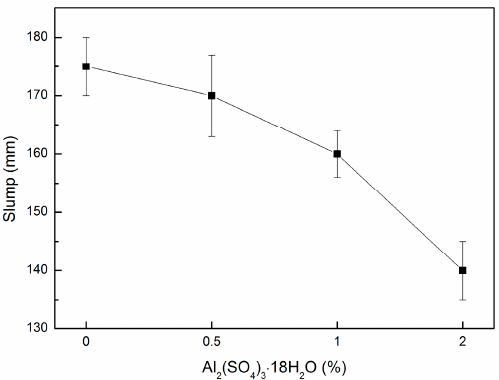
Figure 5. E ff ect of aluminum sulfate on slump of fresh concrete. Figure 5. Effect of aluminum sulfate on slump of fresh concrete. Figure 5. Effect of aluminum sulfate on slump of fresh concrete.